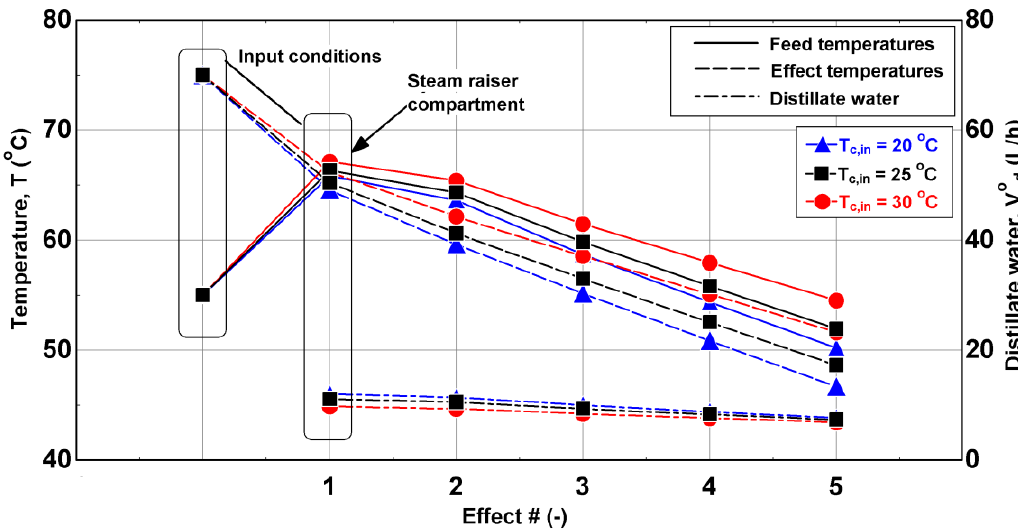
Figure 7. Numerical results of feed water temperatures, effect temperatures and distillate water throughout effects for different cold water temperatures.